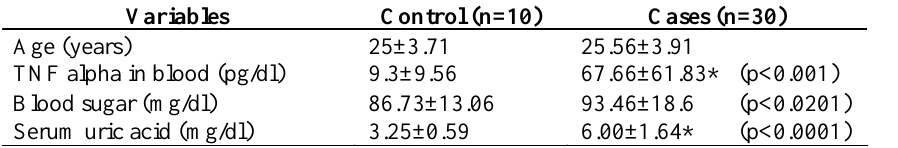
Table I : Comparison of levels of blood sugar, uric acid and TNF-alpha between cases and control